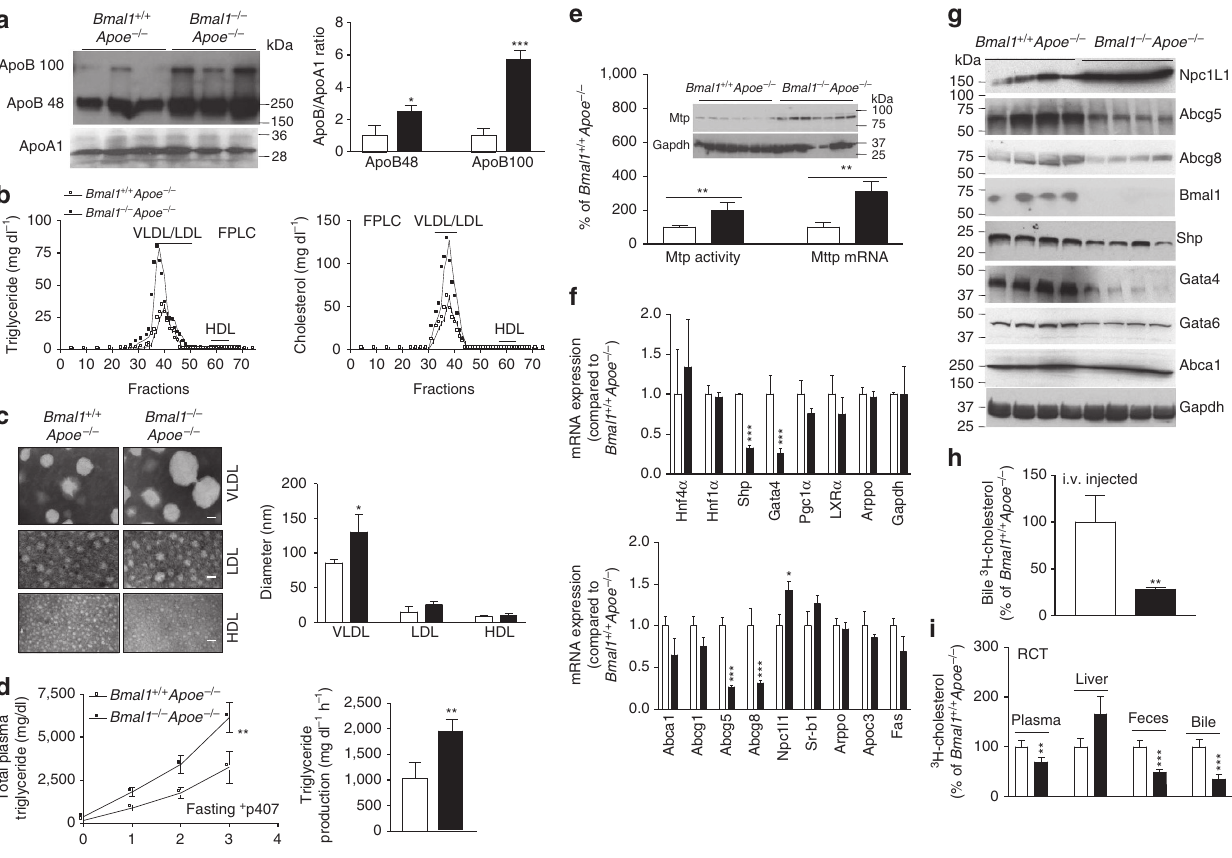
Figure 2 | Effects of Bmal1 deficiency in Apoe (cid:2) / (cid:2) mice. ( a ) Plasma (1 m l) was separated on SDS–PAGE and subjected to western blotting using anti-apoB, anti-ApoA1 antibodies (left). Bands corresponding to apoB100 and apoB48, and apoA1 were quantified and ApoB/ApoA1 ratios were plotted (right). ( b ) Combined ( n ¼ 9 per group) plasma was subjected to FPLC and triglyceride and cholesterol were measured in different fractions. ( c ) VLDL, LDL and HDL prepared by ultracentrifugation were subjected to negative staining and electron microscopy (left). Diameters were quantified and plotted (right). Scale bars, 50nm. ( d ) Overnight fasted animals were injected with P407 and plasma lipids were determined at indicated times. There were more time-dependent increases in plasma triglycerides of Bmal1 (cid:2) / (cid:2) Apoe (cid:2) / (cid:2) than Bmal1 þ / þ Apoe (cid:2) / (cid:2) mice (left). The triglyceride production rates were high in Bmal1 (cid:2) / (cid:2) Apoe (cid:2) / (cid:2) than Bmal1 þ / þ Apoe (cid:2) / (cid:2) mice (right). ( e ) MTP activity, protein and mRNA levels were measured in the livers. ( f ) Livers from Bmal1 (cid:2) / (cid:2) Apoe (cid:2) / (cid:2) and Bmal1 þ / þ Apoe (cid:2) / (cid:2) mice were used to quantify mRNA levels of different transcription factors (top) and lipid transporters (bottom). ( g ) Western blot analysis of different transcription factors and transporters. ( h ) Bmal1 (cid:2) / (cid:2) Apoe (cid:2) / (cid:2) and Bmal1 þ / þ Apoe (cid:2) / (cid:2) mice were intravenously injected with 3 H-cholesterol. Amounts of radiolabelled cholesterol recovered in the bile collected from gall bladder after 3h. ( i ) Amount of cholesterol found after 48h in the plasma, liver, feces and bile after intraperitoneal placement of cholesterol loaded J774 cells in Bmal1 þ / þ Apoe (cid:2) / (cid:2) and Bmal1 (cid:2) / (cid:2) Apoe (cid:2) / (cid:2) mice. Data in a , c , e , f , h and i are mean ± s.d., n ¼ 9; unpaired Student’s t -test. * P o 0.05, ** P o 0.01 and *** P o 0.001. Data in d are mean ± s.d., n ¼ 9; two-way ANOVA. ** P o 0.01. Error bars represent s.d.